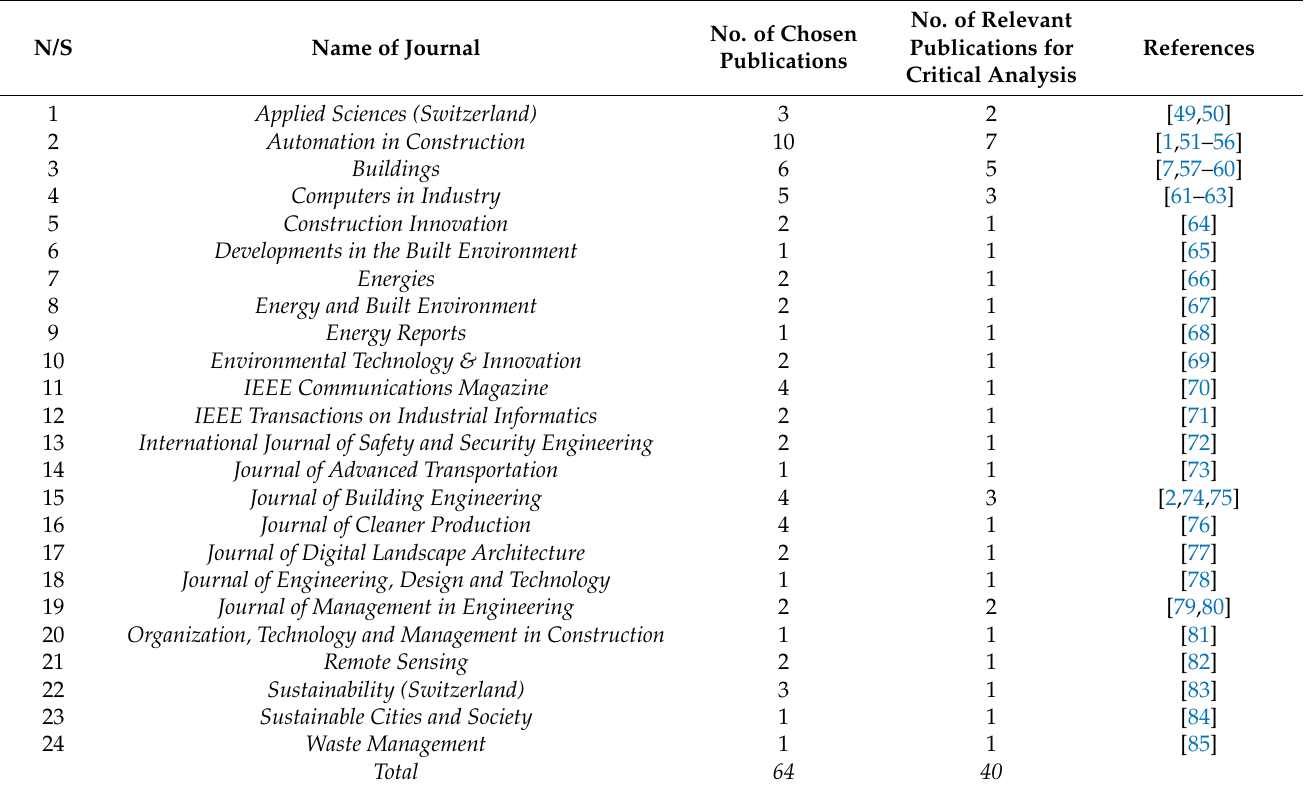
Table 2. Search outcomes of the pertinent papers for the